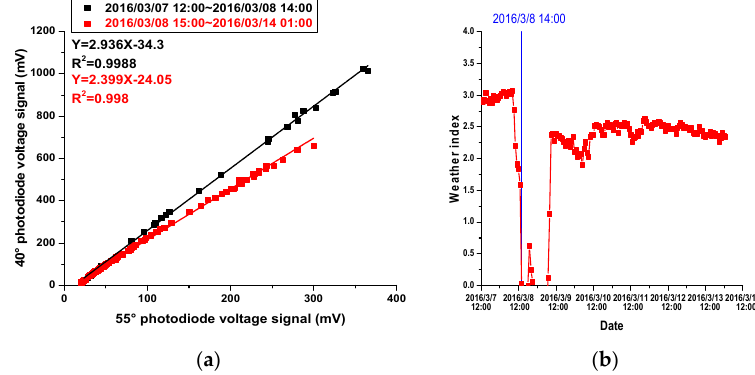
Figure 10. Parameters of the weather index: ( a ) Scatter plot of the 55° photodiode voltage signals vs. the 40° photodiode voltage signals, ( b ) Variation of the weather index during the measurement period. Variations of the meteorological parameters during the experiment are illustrated in Figure